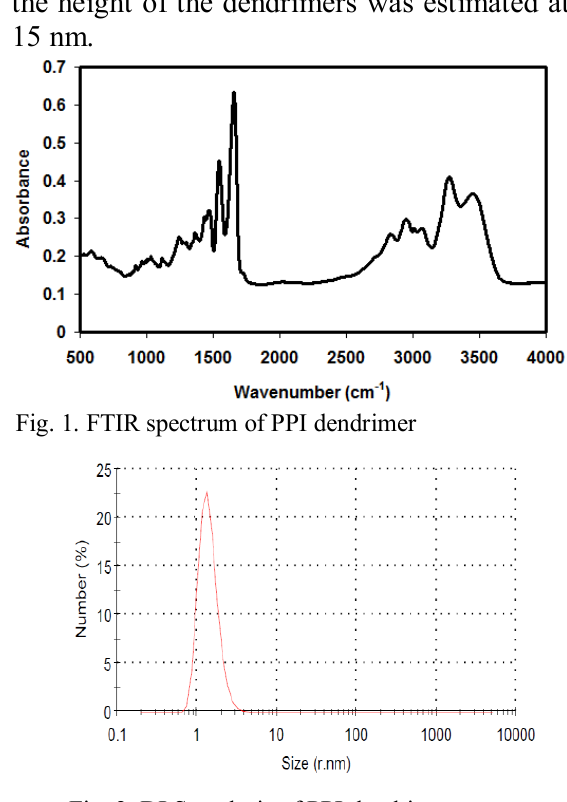
Fig. 2. DLS analysis of PPI